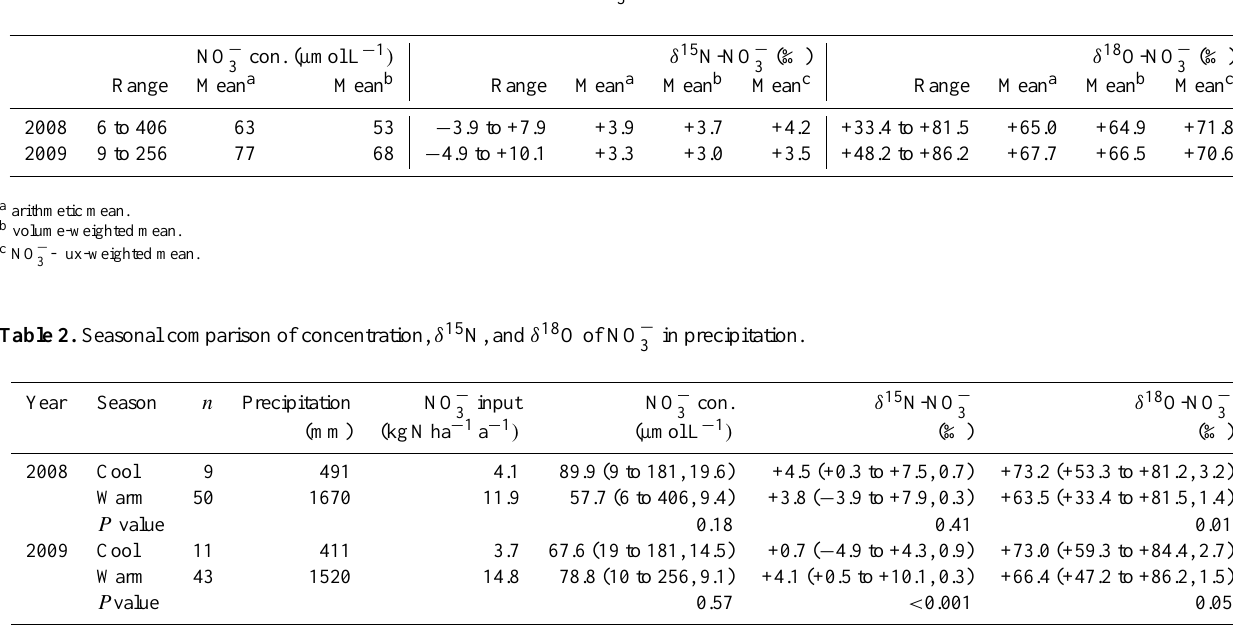
Table 1. Ranges and means of concentration, δ 15 N, and δ 18 O of NO −